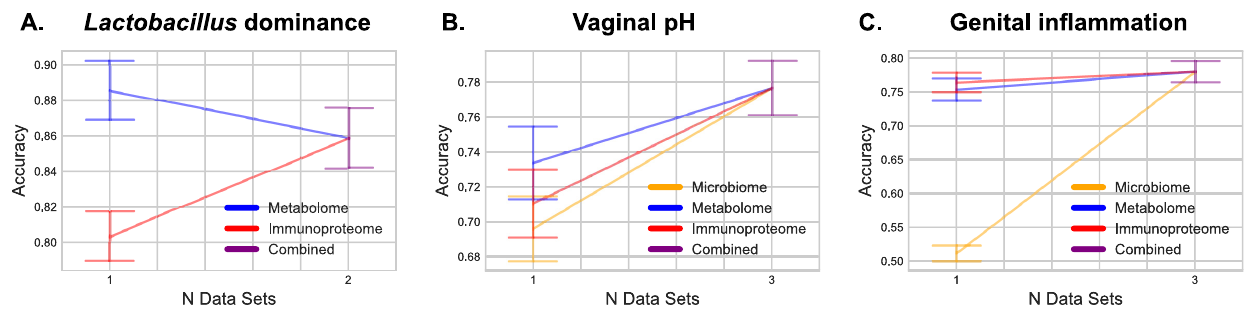
Fig 7. Integrating multiple–omics datasets does not dramatically improve overall prediction accuracy; however, different integration of various measurements are needed for the best prediction of distinct features. Graphs show stepwise accuracy levels for Lactobacillus dominance ( A ), vaginal pH ( B ) and genital inflammation ( C ) when Random Forest models are trained on a single omics dataset or combined data containing 2–3 omics datasets. Lactobacillus dominance can be explained mostly by metabolome data, vaginal pH by metabolome and microbiome datasets, and genital inflammation by metabolome and immunoproteome datasets. Combining omics datasets leads to higher average accuracy scores for Lactobacillus dominance and vaginal pH and genital inflammation classifications, but not for Lactobacillus dominance classification.